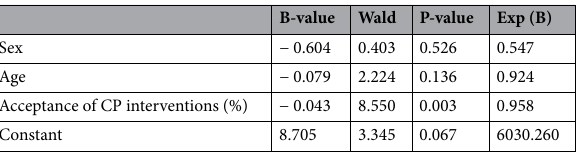
Table 5. Logistic regression analysis of treatment guidelines adherence for